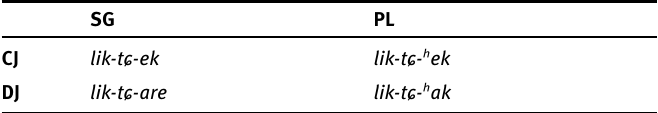
Table 4: Conjunct and disjunct marking in Bunan (verb lik - ‘to make’)